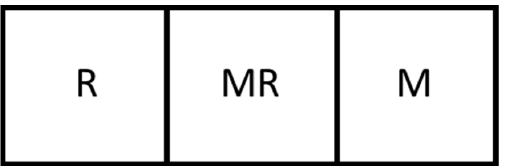
Figure 1. Example of a module-based design with a reactor module (R), membrane reactor (MR), and membrane separator (M).